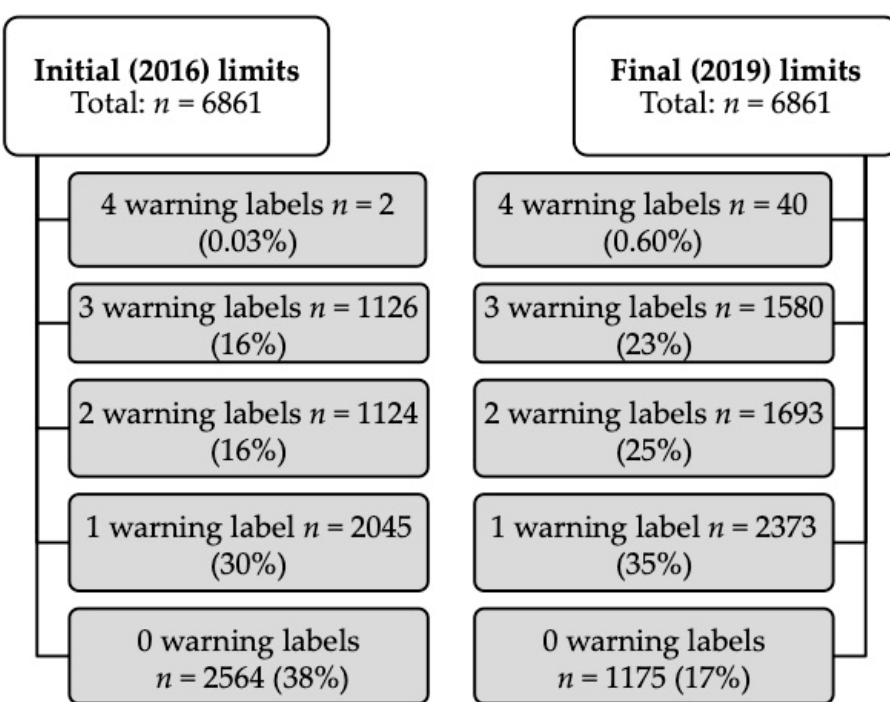
Figure 1. Flow chart with number of products estimated to carry between zero and all four front-of-package (FOP) warning labels considering either the initial (2016) or final (2019) limits, respectively.